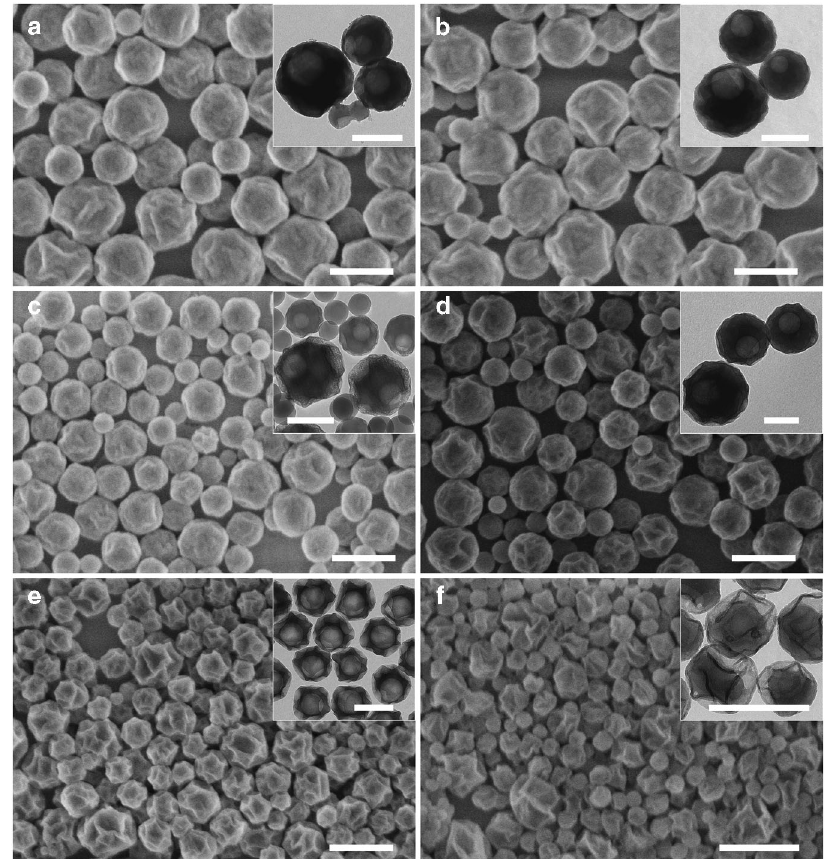
Fig. 3 Particles prepared with aqueous phases of different pH. The mass ratio of the inner water phase to the oil phase (PEOS:styrene 1:1) is 1:10, and the primary W/O emulsion to the outer water phase is 1:10. The pH of both inner and outer aqueous phases is delicately adjusted using an ammonia solution or hydrochloric acid. a Inner pH 3, outer pH 7. b Inner pH 5, outer pH 7. c Inner pH 9.5, outer pH 7. d Inner pH 7, outer pH 9.5. e Inner pH 7, outer pH 10. f Inner pH 7, outer pH 10.7. FESEM images with scale bars of 500 nm are shown and the insets are the corresponding TEM images with scale bars of 200